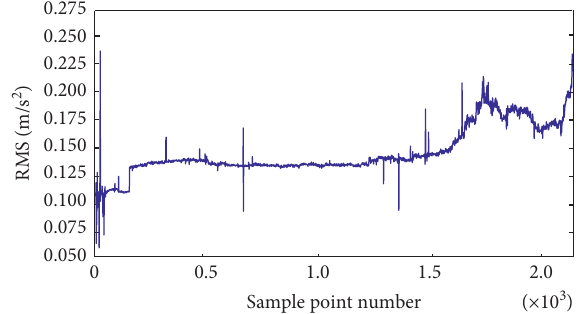
Figure 3: HI curve of the full bearing life cycle.